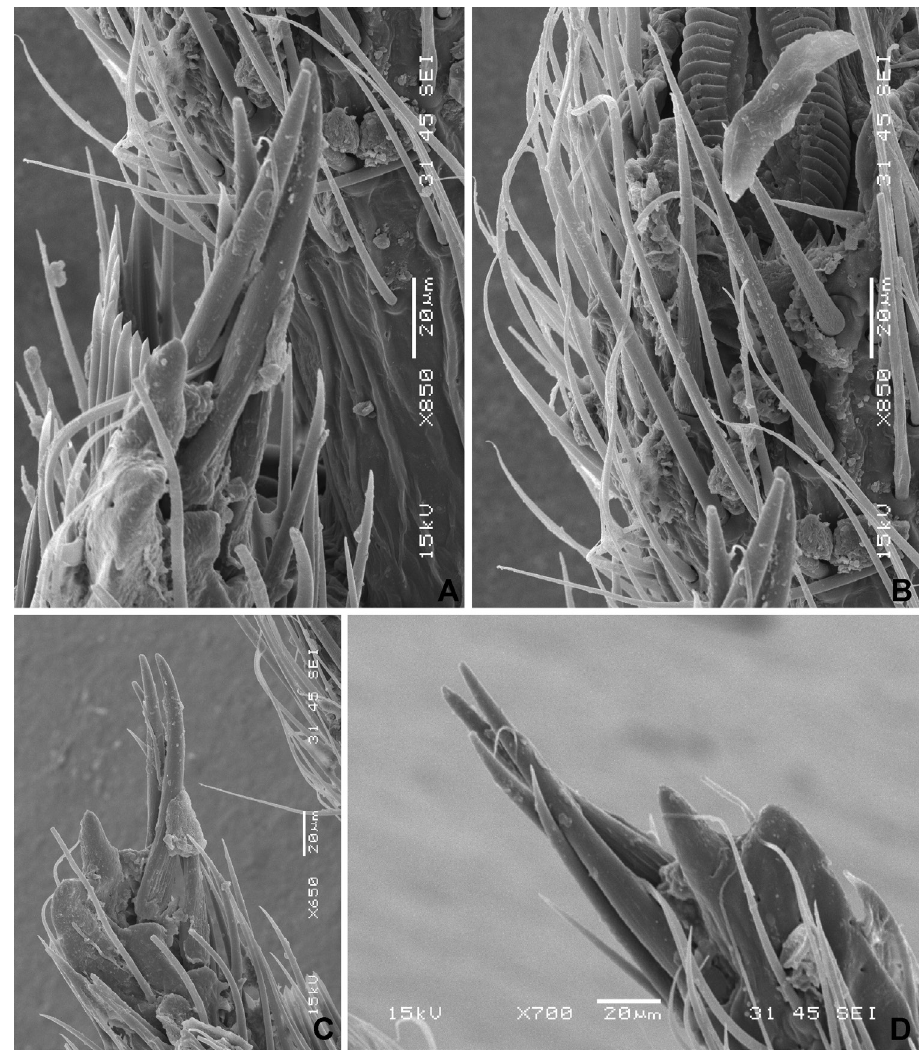
Figure 4. Xenicocephalus tomhenryi sp. n., female holotype, left foreleg, scanning electron micrographs A apicitibial armature, ventral view B tarsal armature, ventral view C apicitibial armature, posterior view D apicitibial armature, anterior